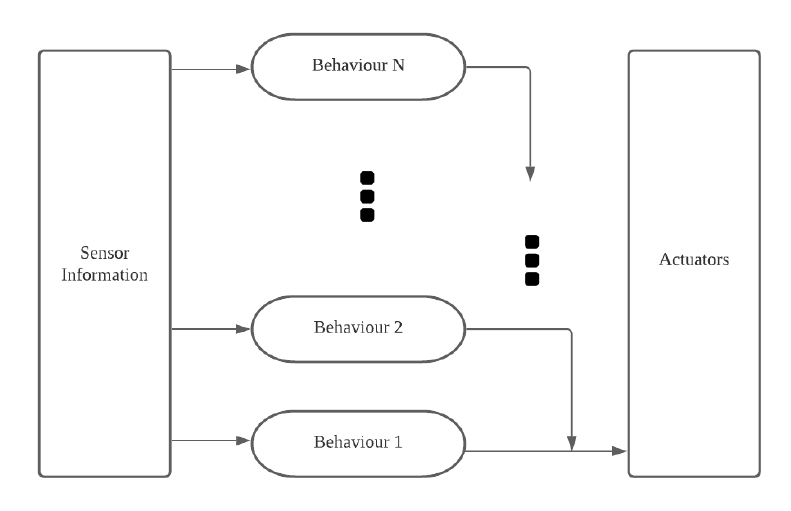
Figure 5. The subsumption